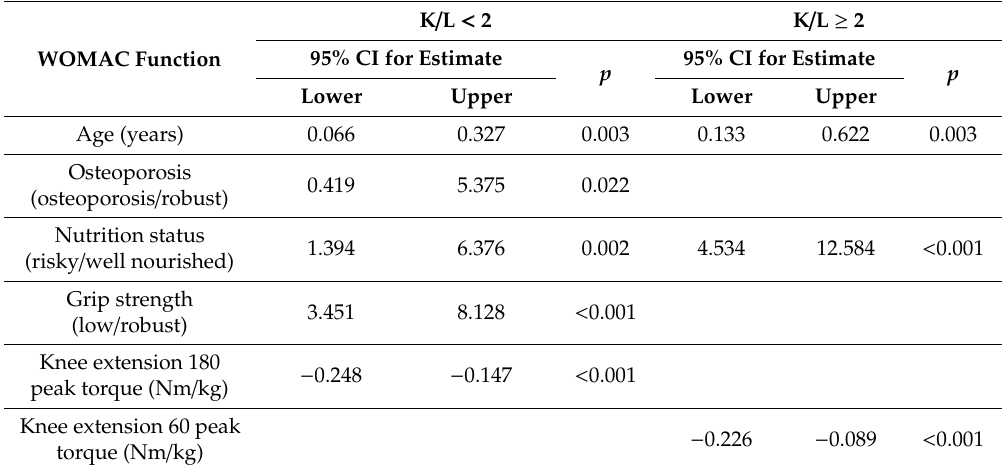
Table 5. Results of stepwise multiple regression analysis for the WOMAC function.